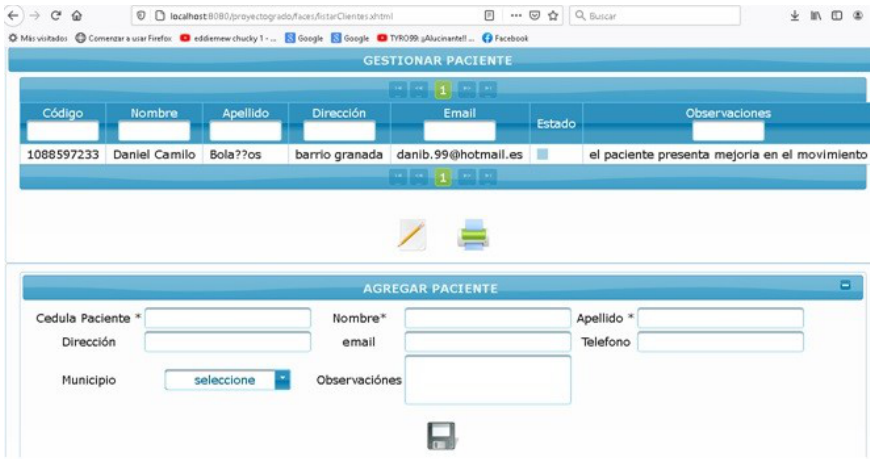
Figure 7. Graphical interface of the database of patients with upper torso